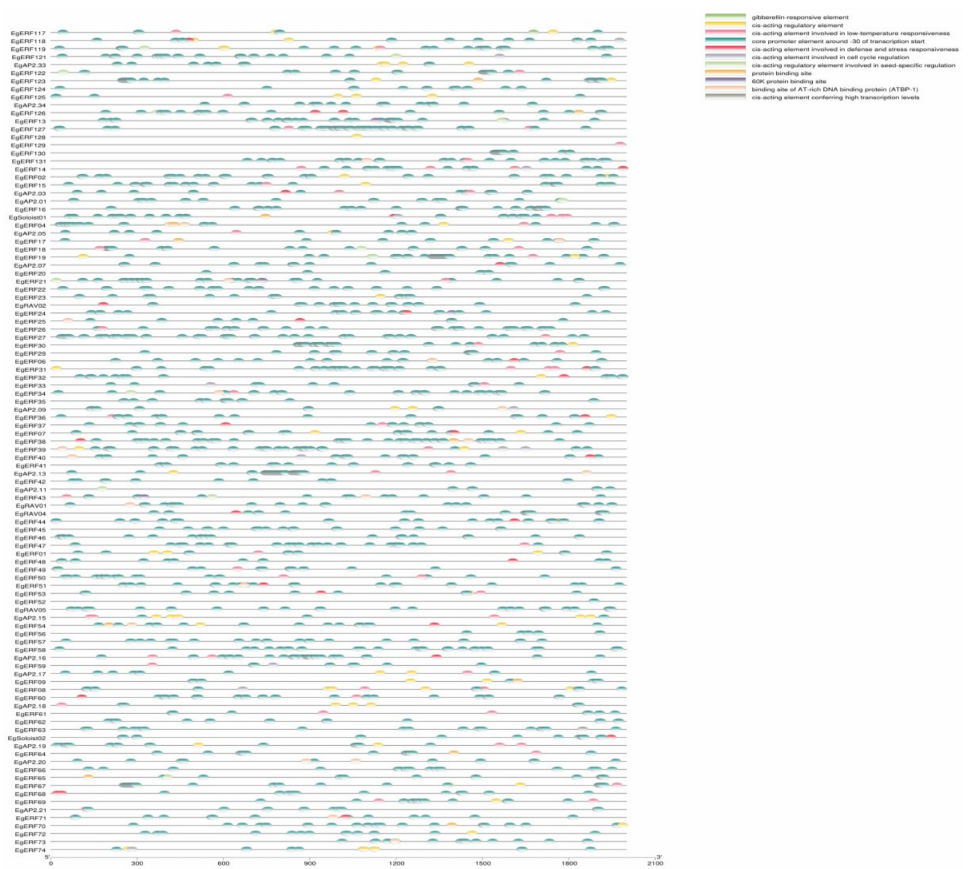
Figure 6. Schematic representations of cis-regulatory elements present in AP2/ERF s as investigated via the PlantCARE